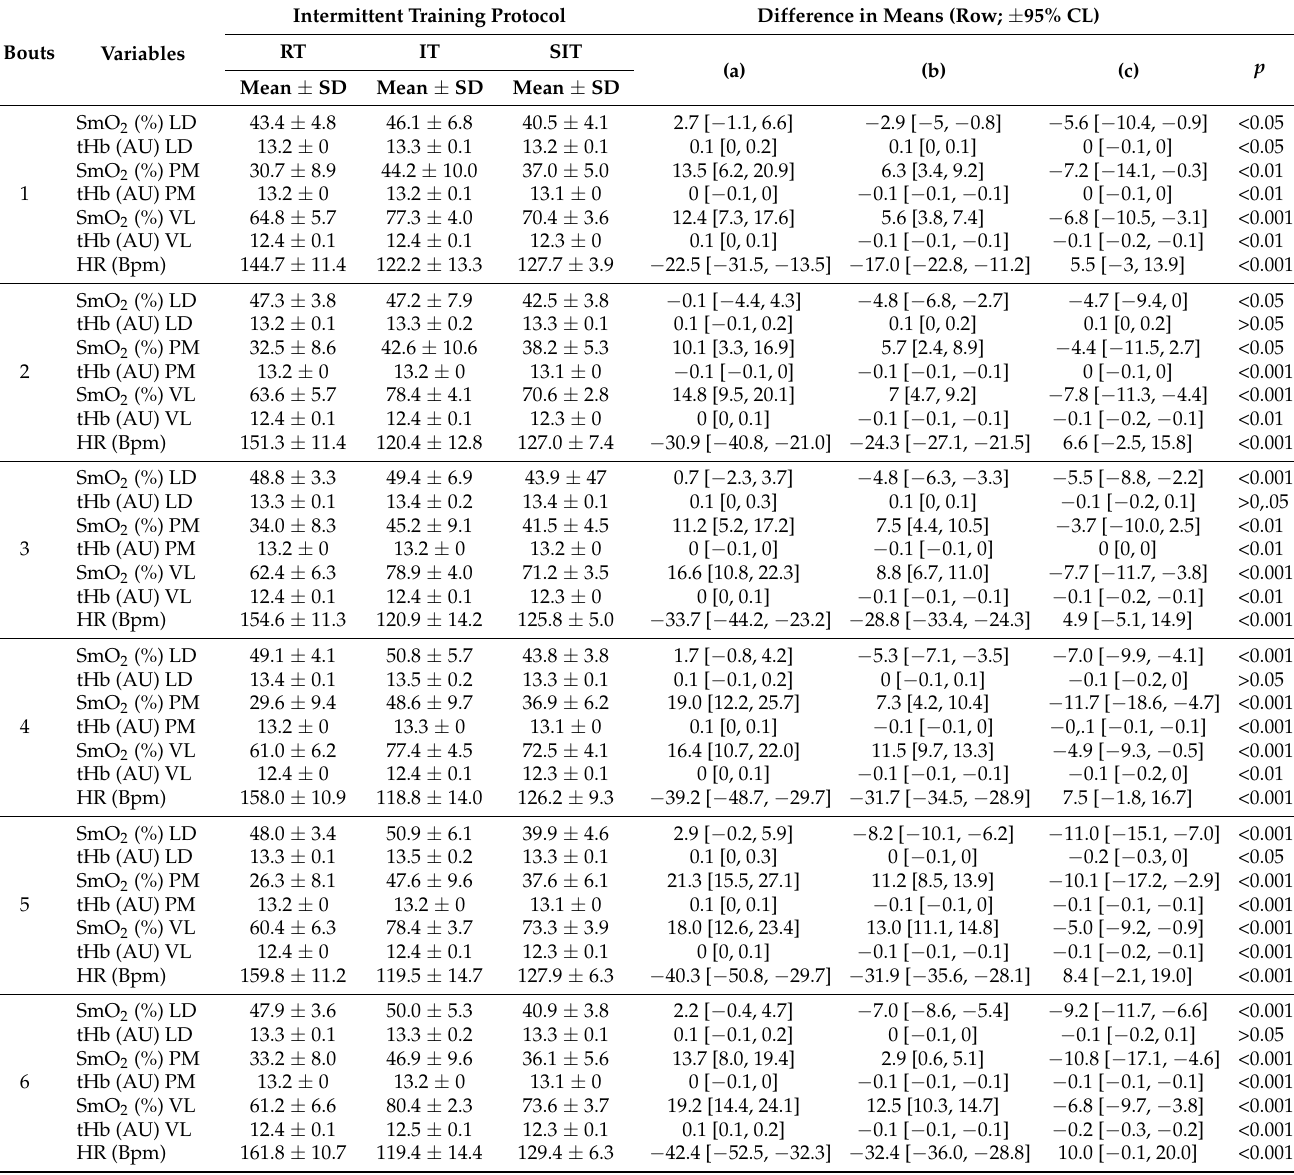
Table 3. Characterization and inferential analysis of the considered variables according to different intermittent training protocols during exercise